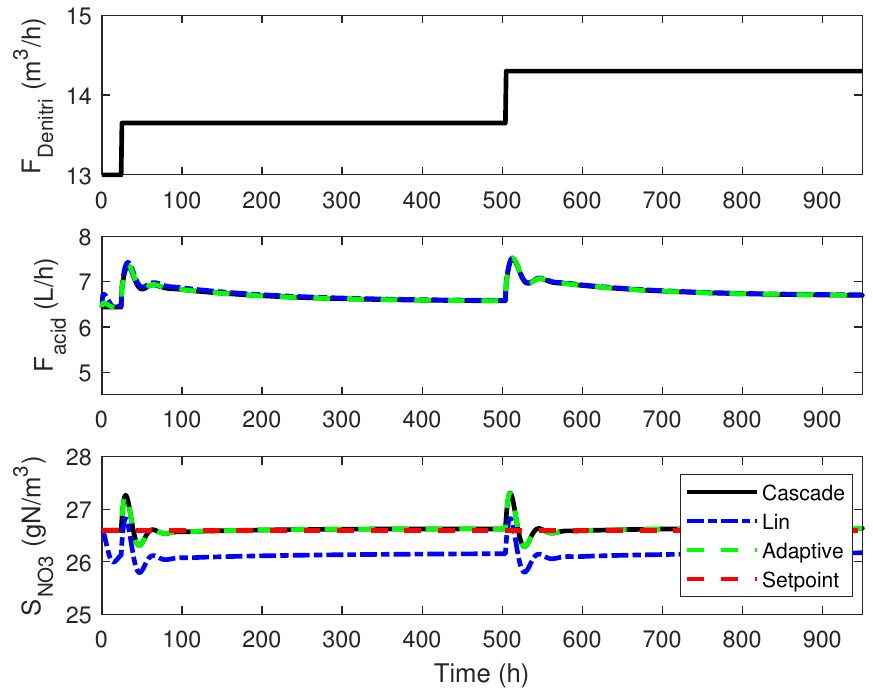
Figure 16. Nitrate concentration and acid flowrate evolutions for 5 to 10% variations in bypass flowrate ( F Denitri ) using different controllers: cascade ( Cascade ), classical linearizing ( Lin ) and adaptative linearizing controllers ( Adaptive